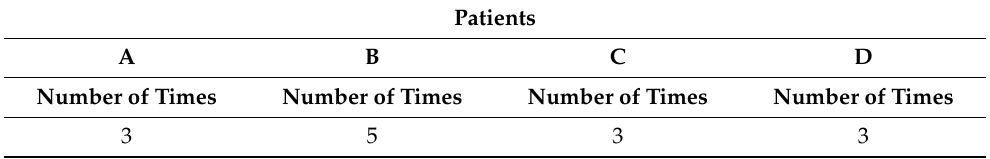
Table 16. Results of eye movements considering time lags in the preliminary indoor experiment.